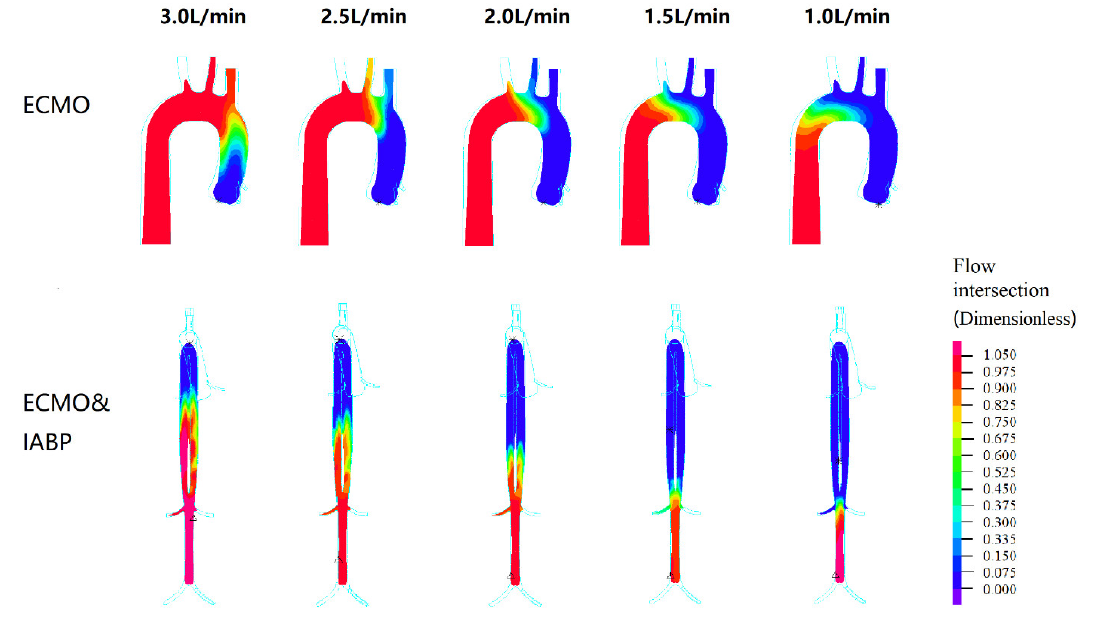
Figure 6. The flow intersection as a dimensionless parameter during left ventricular and V-A ECMO. The flow of the left ventricle is shown in blue, and the flow of the VA ECMO is shown in red.